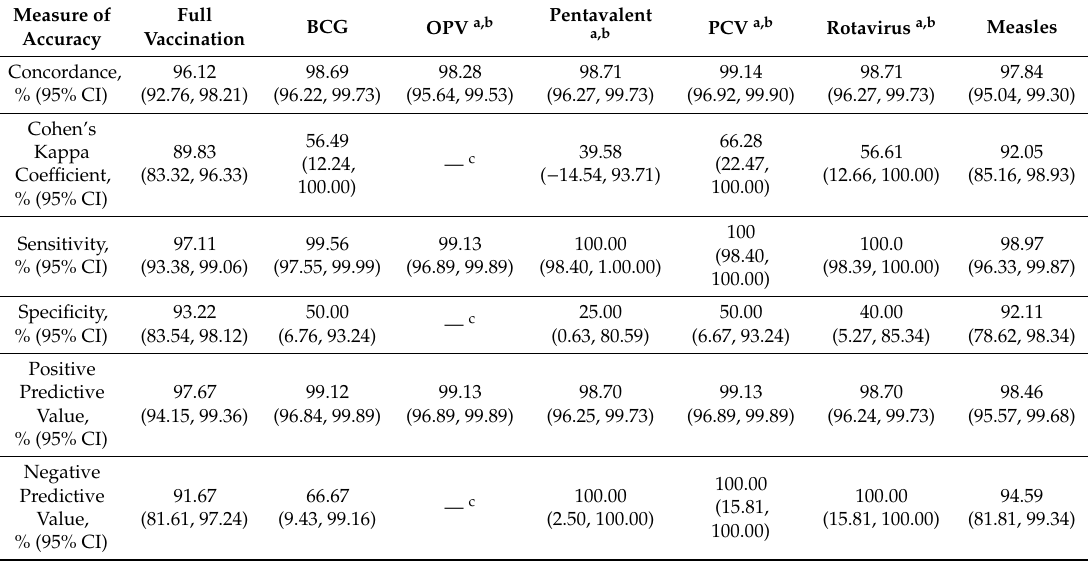
Table 5. Measures of recall accuracy.